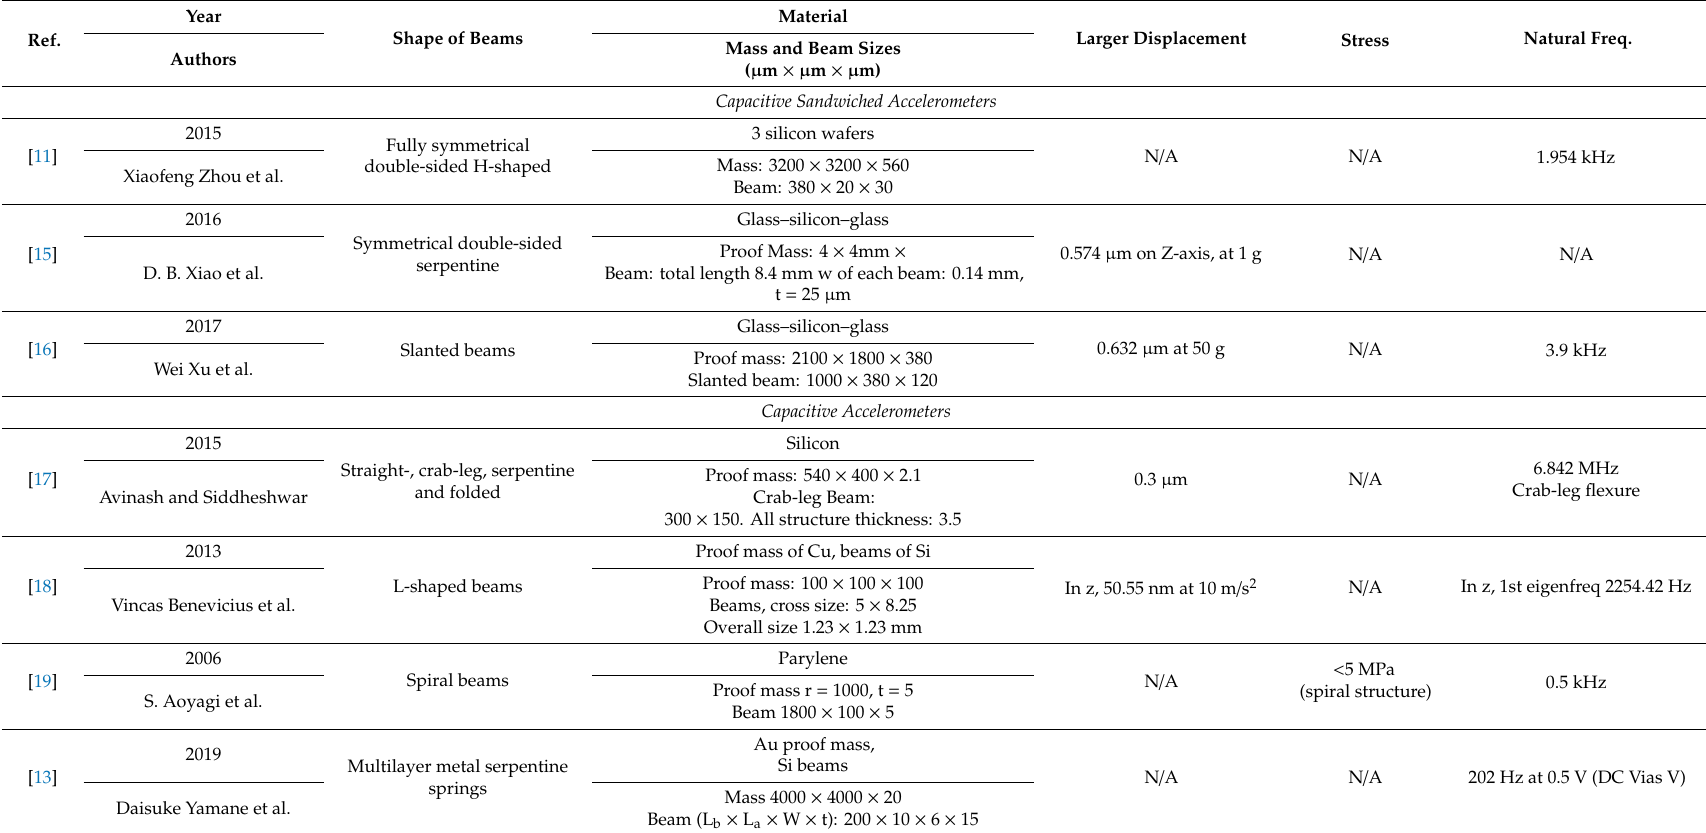
Table 2. Accelerometers with di ff erent beam